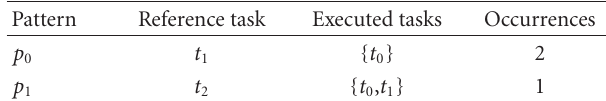
Table 1: Example of preemption